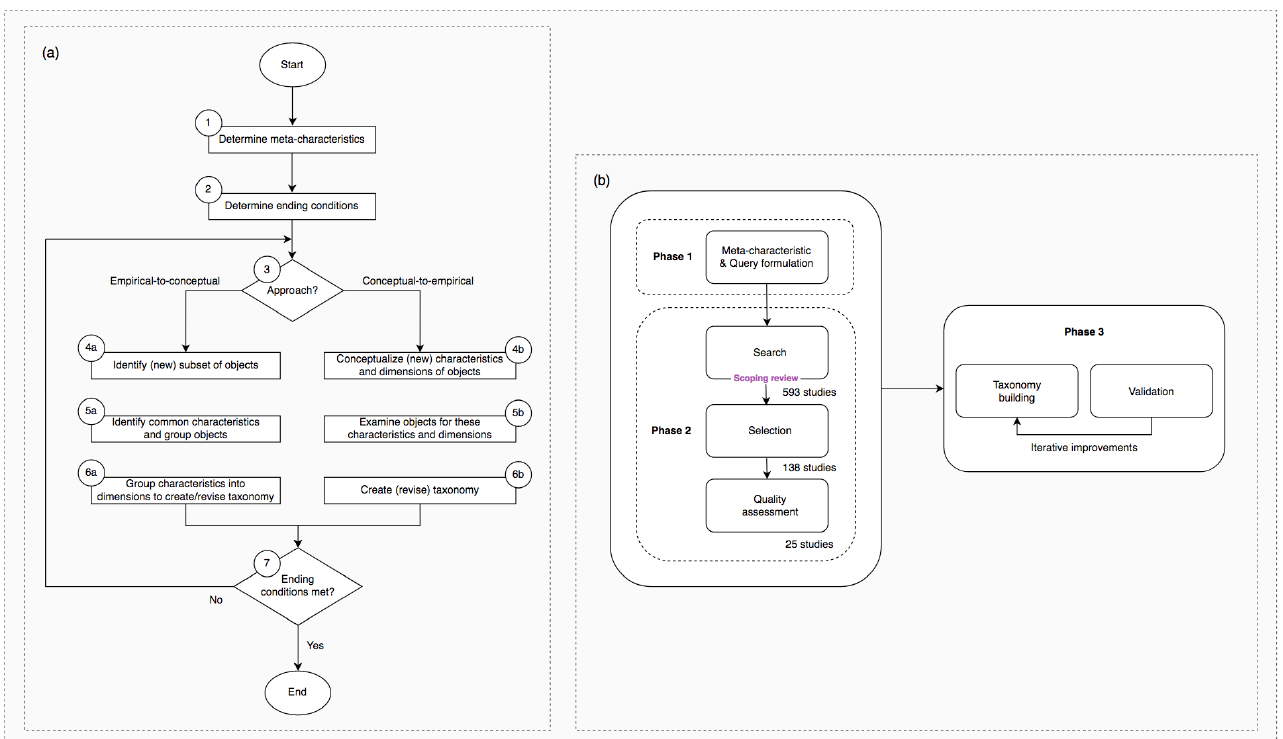
Figure 1. Iterative taxonomy development process flow ( a ) and methodological details